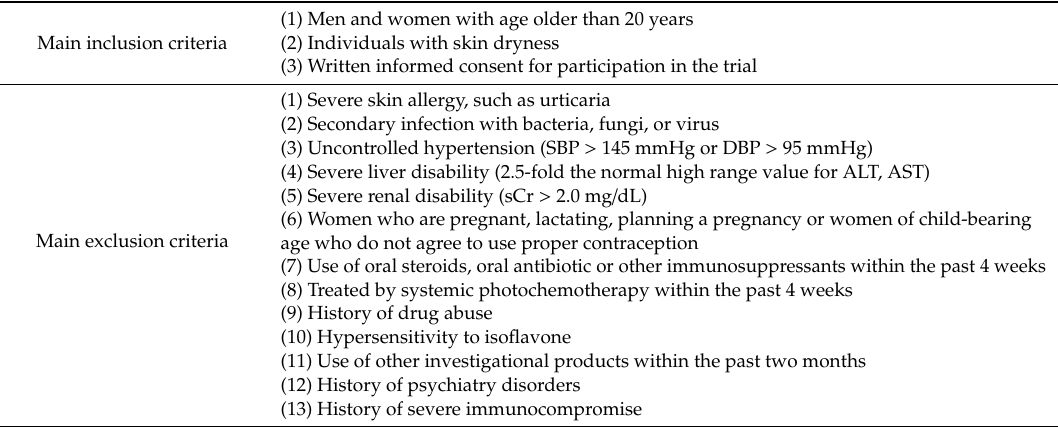
Table 1. Inclusion and exclusion criteria.